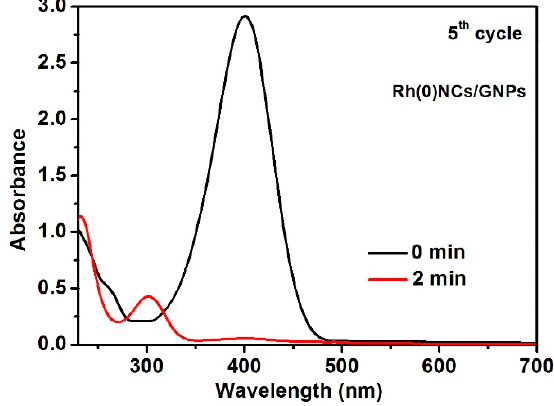
Scheme 1. Proposed mechanism for the reduction 4-nitrophenol to 4-aminophenol by Rh(0)NCs/GNPs.